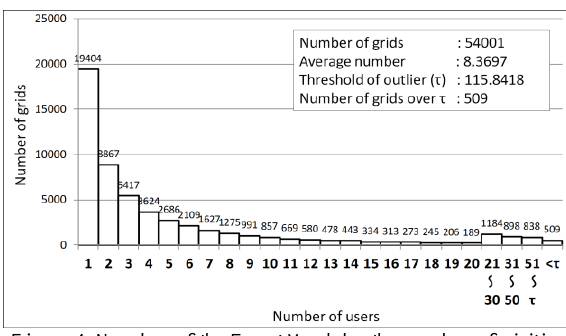
Figure 4. Number of the Event Mesh by the number of visiting users with Events (May 5, 2012)